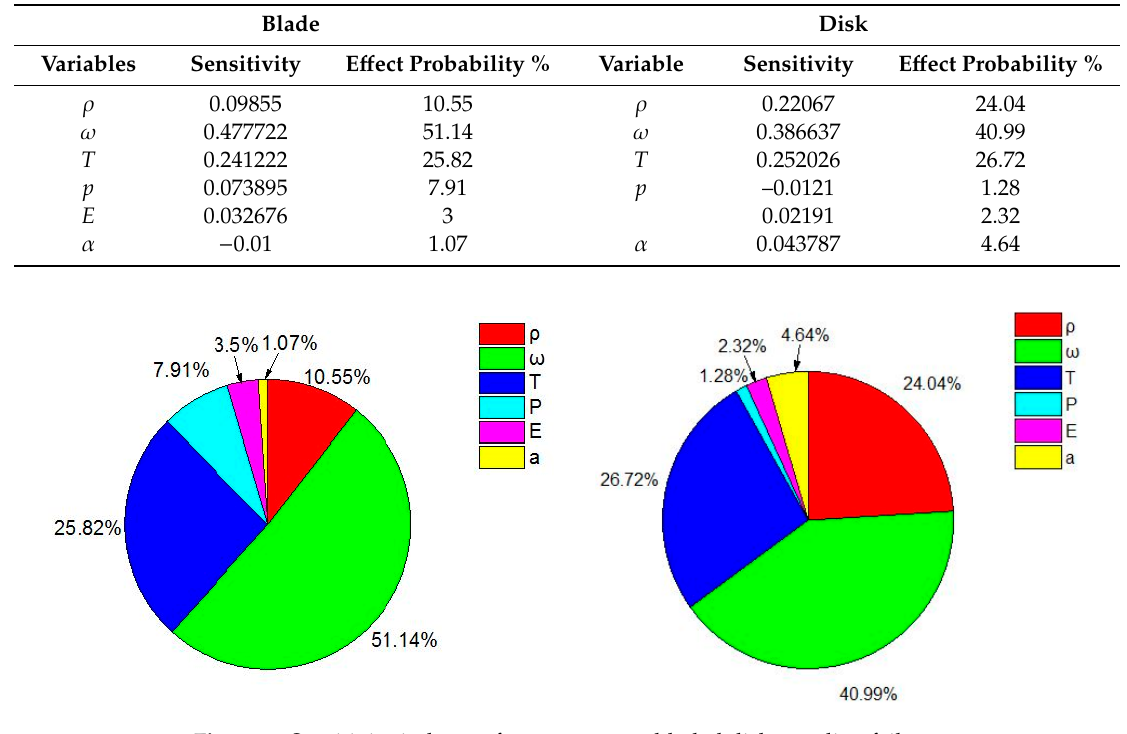
Table 4. Optimal level threshold and allowable mean of a bladed disk.